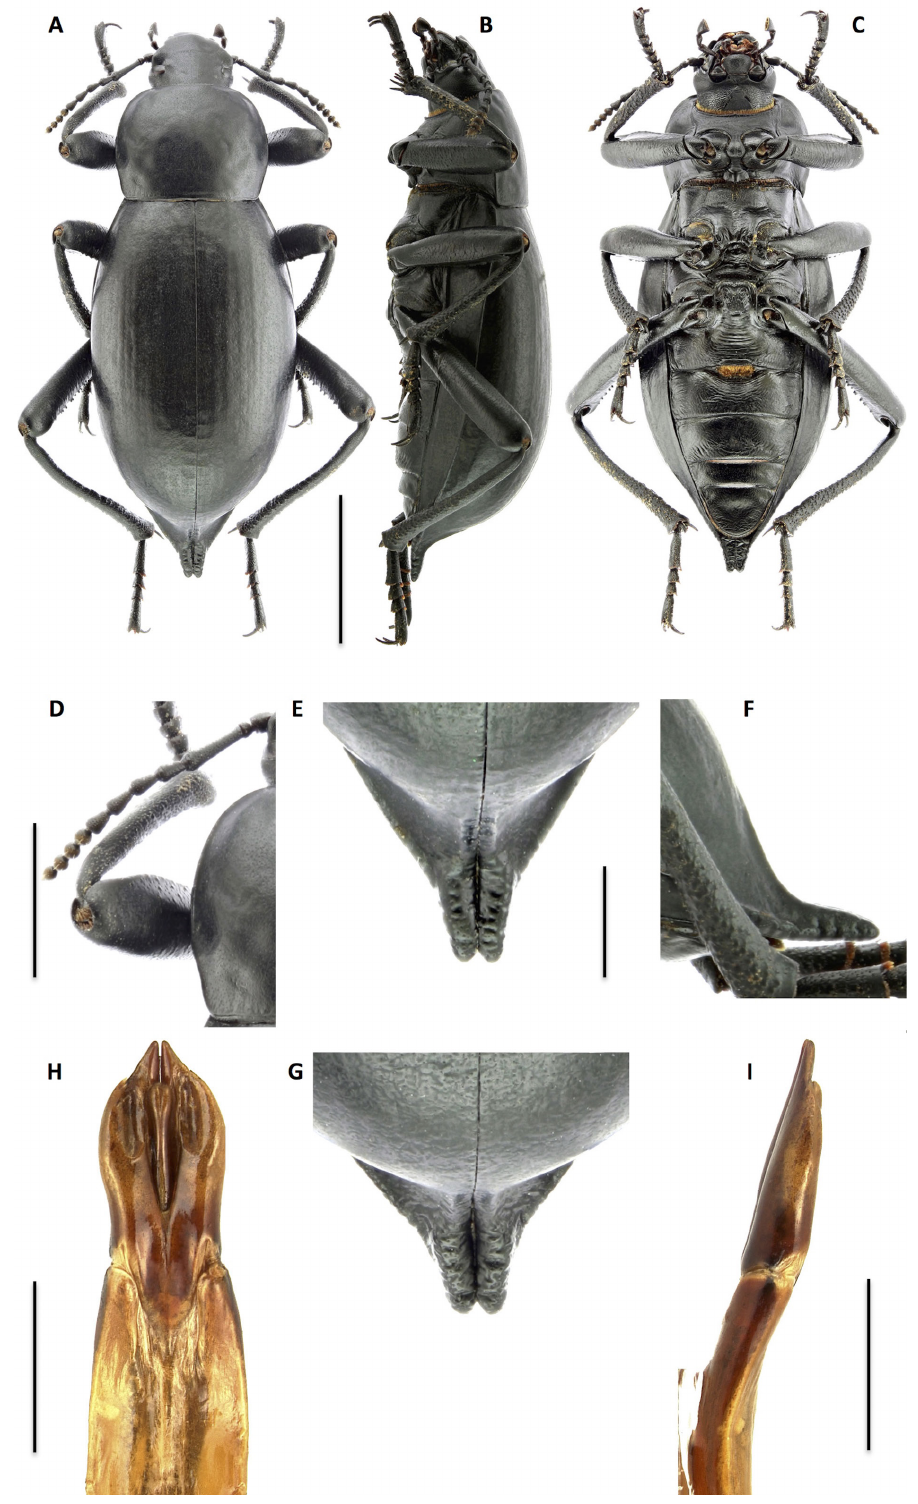
Fig. 2. Blaps intermedia Soldati sp. nov. A . ♂, habitus (dorsal view). B . ♂, habitus (lateral view). C . ♂, habitus (ventral view). D . ♂, left antenna (dorsal view). E . ♂, mucro (dorsal view). F . ♂, mucro (lateral view). G . ♀, mucro (dorsal view). H . ♂, aedeagus (ventral view). I . ♂. aedeagus (lateral view). Scale bars: A–C = 10 mm; D = 5 mm; E–I = 2